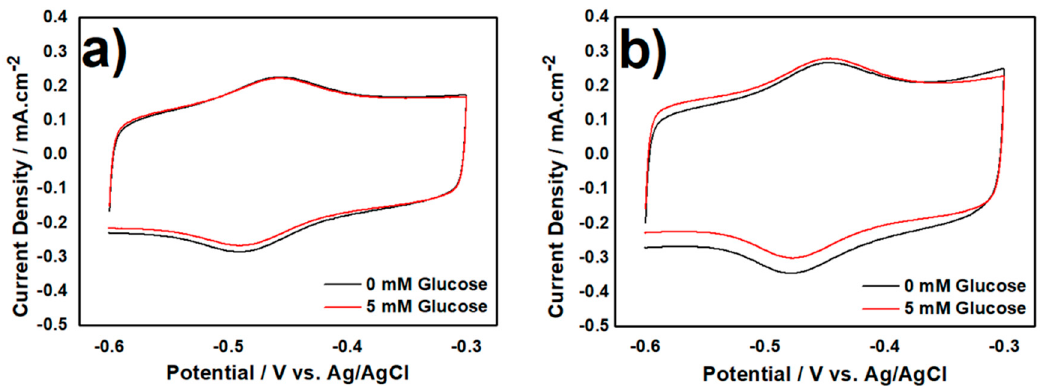
Figure 3. CV curves of ( a ) CNT/GOx and ( b ) CNT/PEI/GOx at scan rate 100 mV · s − 1 with absence (black) and presence (red) of 5 mM glucose in the electrolyte. All experiment conducted under aerobic condition and 0.1 M PBS pH 7.4 acted as the electrolyte.